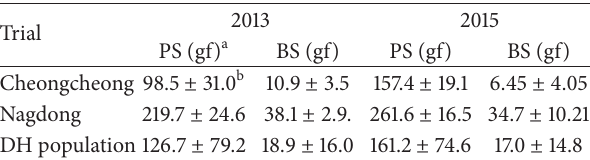
Table 1: Evaluation for shattering degree by force